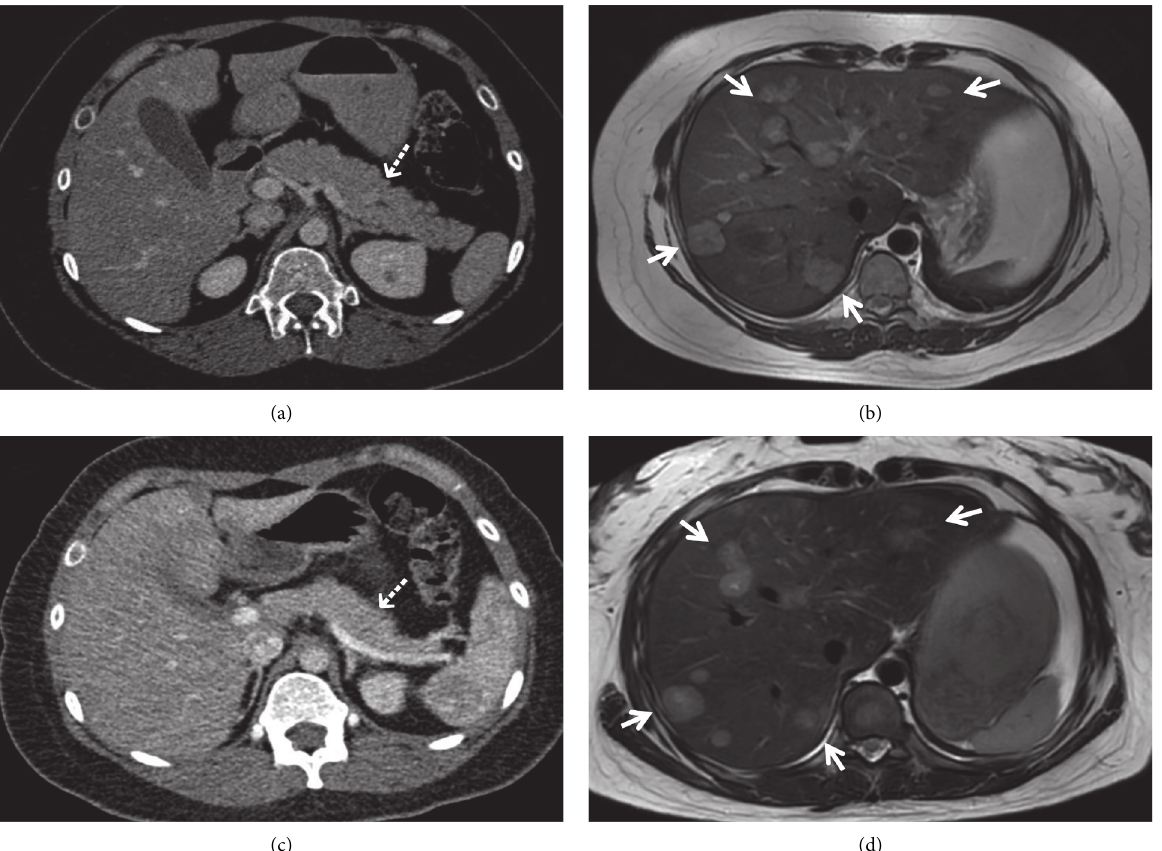
Figure 1: Abdominal CTand MRI images before (a and c) and after 7 cycles of octreotide LAR therapy (b and d) (case 1). (a) The abdominal CT image demonstrated a solid nodule in the body-tail junction of the pancreas (dotted arrow). (b) The abdominal MRI demonstrated multiple blood-rich nodules in the liver (arrow). (c) The abdominal CT image demonstrated that the pancreatic solid nodule was unclear after 7 cycles of octreotide LAR therapy (dotted arrow). (d) The abdominal MRI demonstrated that the sizes and numbers of hepatic metastatic nodules remained stable (arrow). CT: computed tomography. MRI: magnetic resonance